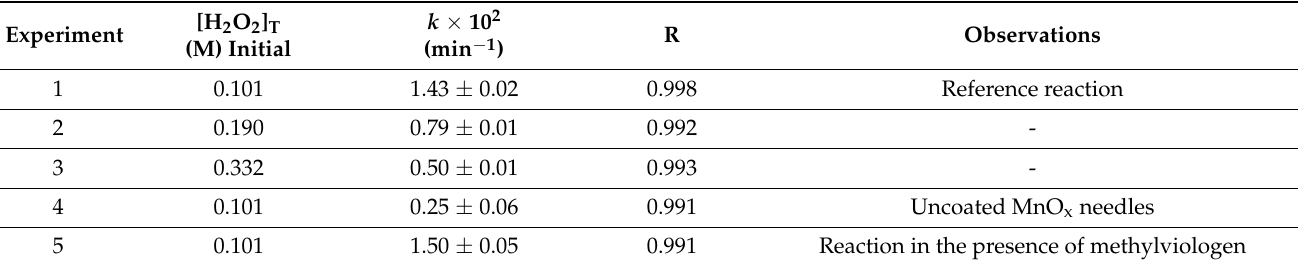
Figure 9. ( a ). ln([H 2 O 2 ]/[H 2 O 2 ] 0 ) vs. time plot for 1mg/mL of Mn-nanozyme and different H 2 O 2 concentrations; ( b ). ln([H 2 O 2 ]/[H 2 O 2 ] 0 ) vs. time plot for 1mg/mL of Mn-nanozyme, [H 2 O 2 ] 0 = 0.1 M, and [methylviologen] = 0.2 M; ( c ) ln([H 2 O 2 ]/[H 2 O 2 ] 0 ) vs. time plot for [H 2 O 2 ] 0 = 0.1 M, 1 mg/mL of Mn-nanozyme, and 0.57 mg/mL of catalyst without silica. Table 2. First-order constants calculated from regression lines of Figure 9.